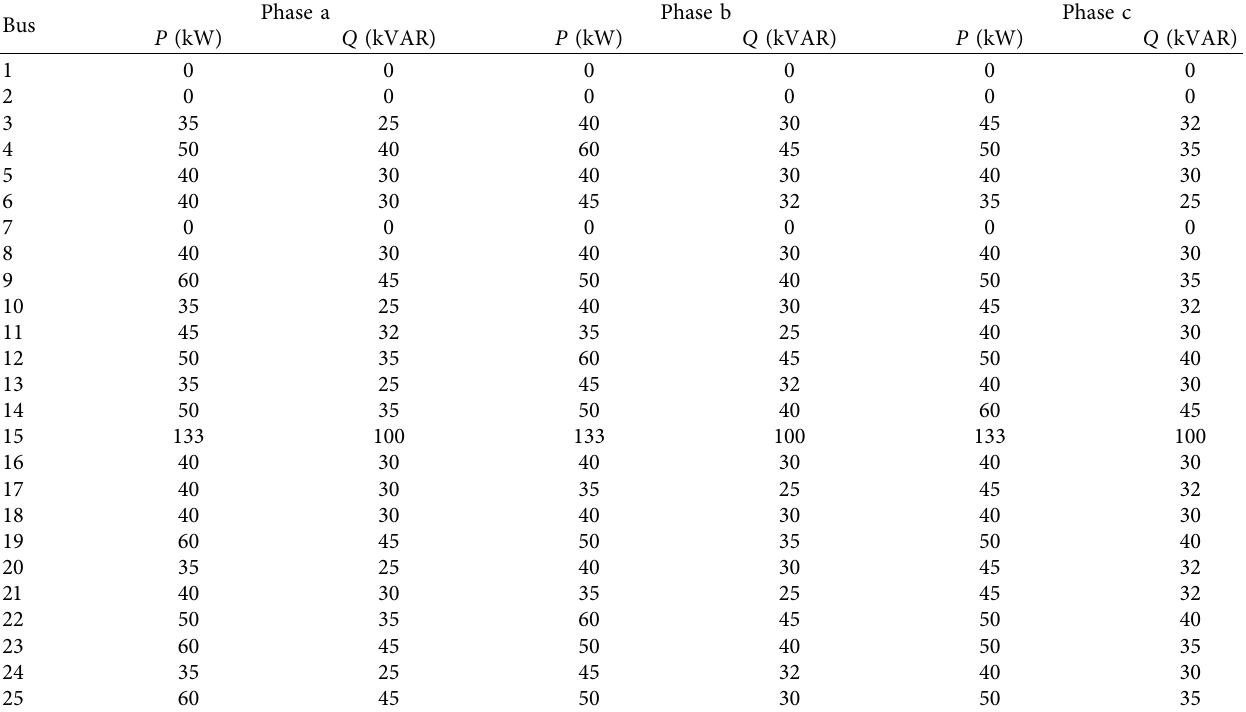
Table 6: Loads of 25-bus network.